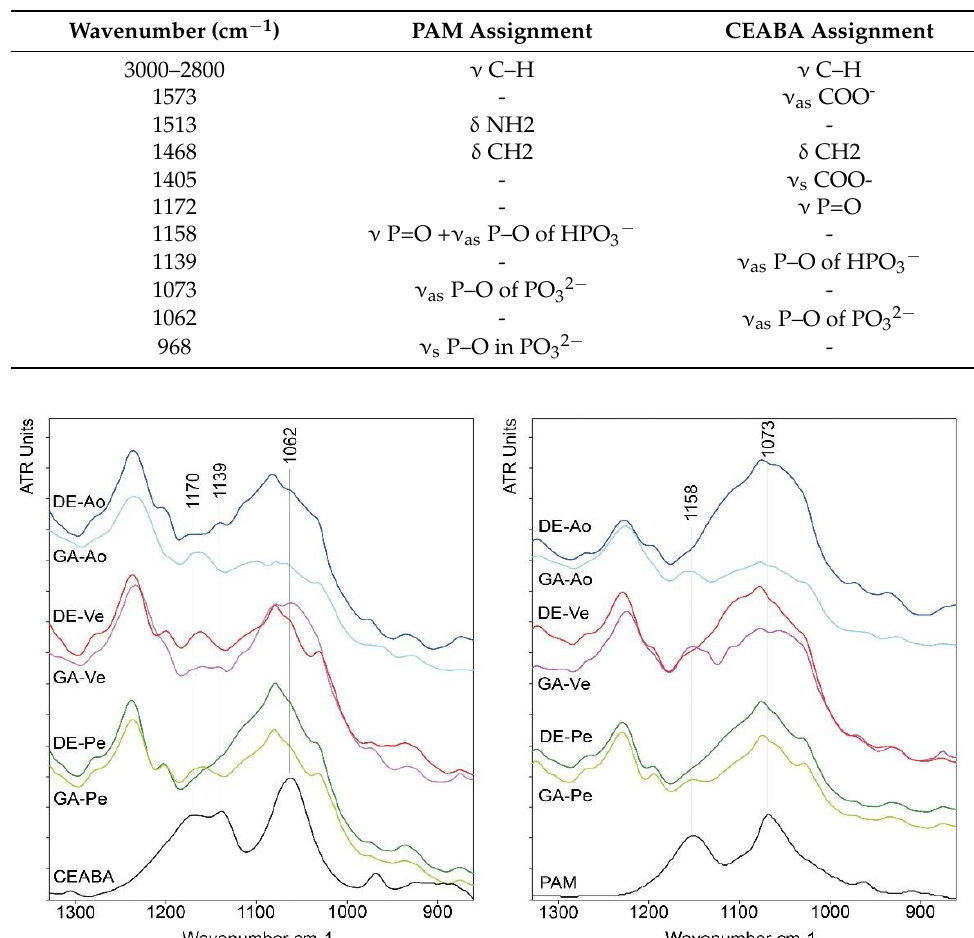
Figure 4. Difference FTIR spectra of the cross-linked biomaterials treated with PAM and CEABA (GA + PAM—red line, GA + CEABA—green line, DE + PAM—blue line, DE + CEABA—pink line).